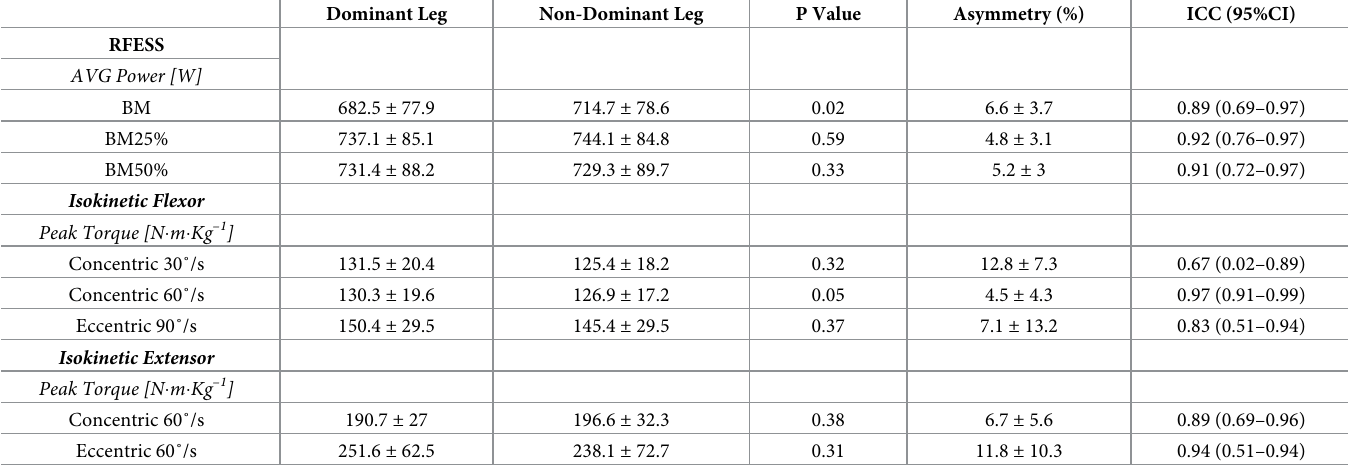
Table 1. Descripitve information for dominant and non-dominant leg average power and peak torque, level of asymmetry (%) and reliability in Rear Foot Elevated Split Squat (RFESS), Isokinetic Flexor and Isokinetic Extensor. Dominant